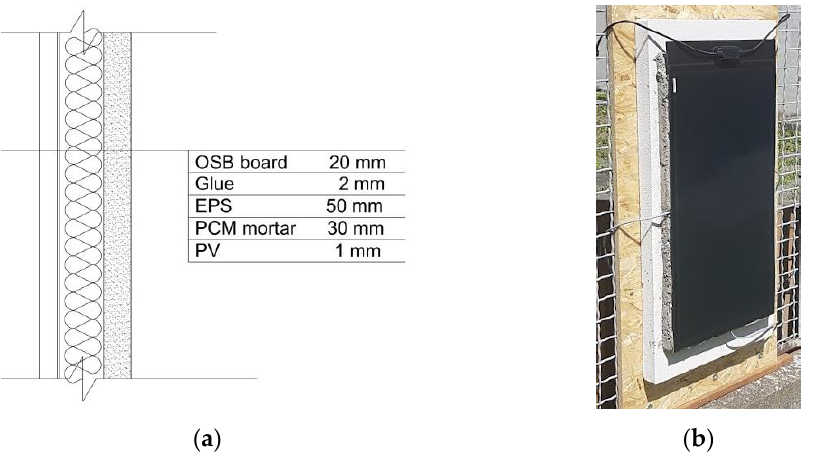
Figure 1. Analyzed construction: ( a ) cross-section of the model, ( b ) experimental component.